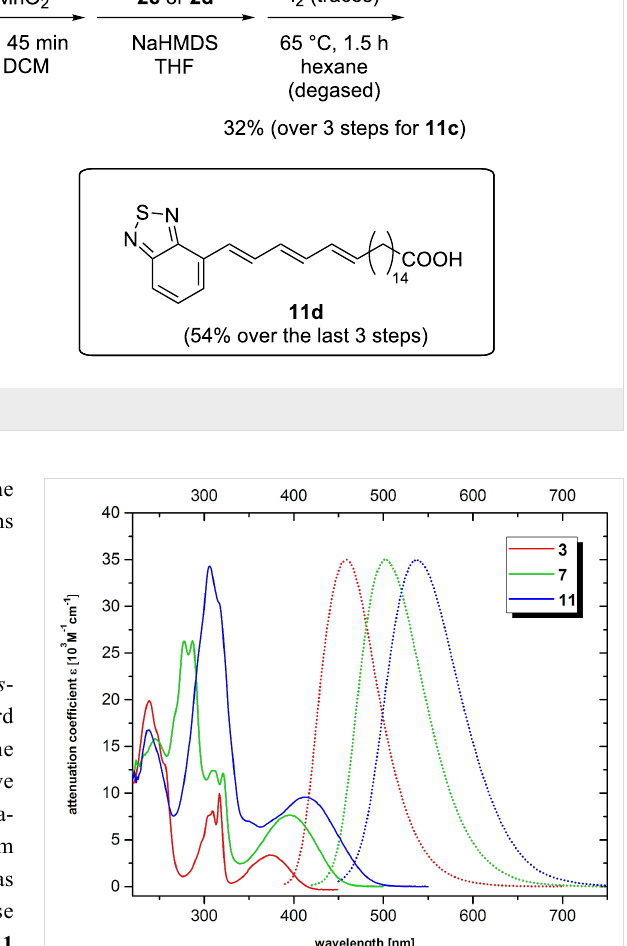
Figure 2: Absorption spectra of fatty acids 3 , 7 and 11 . Solid lines show the UV absorption while dashed lines show fluorescence emis- sion. Excitation was performed at the longest wavelength in each